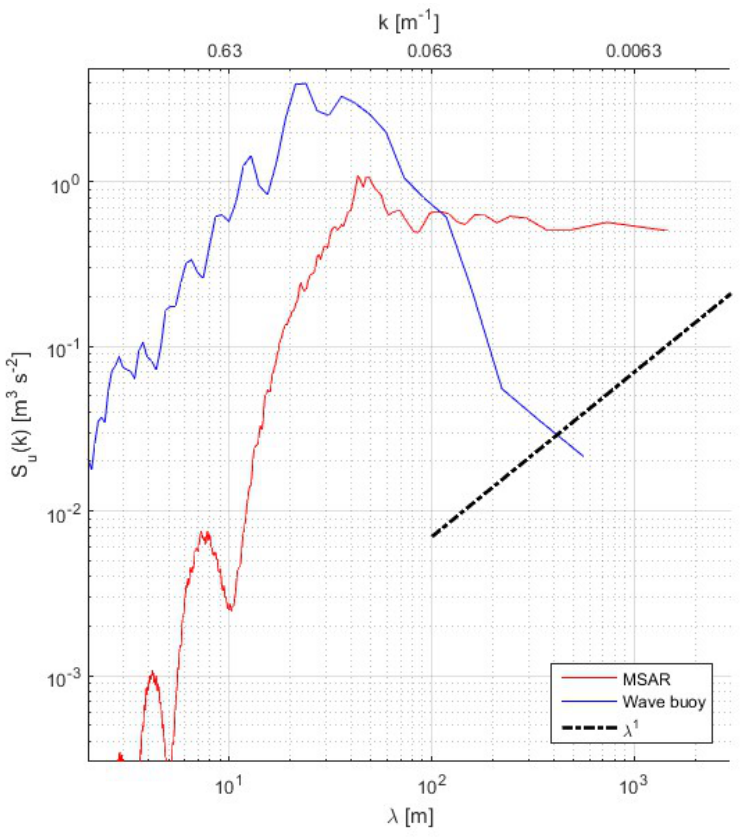
Figure 17. The red curve shows MSAR interferogram velocity (Figure 16, top panel) power spectrum in across-track (range) direction, averaged along realizations in the azimuthal direction. Blue curve shows wave energy obtained from a co-located wave buoy. Dash-dotted line gives the λ 1 power law, same as in Figure 11 and Equation (4).